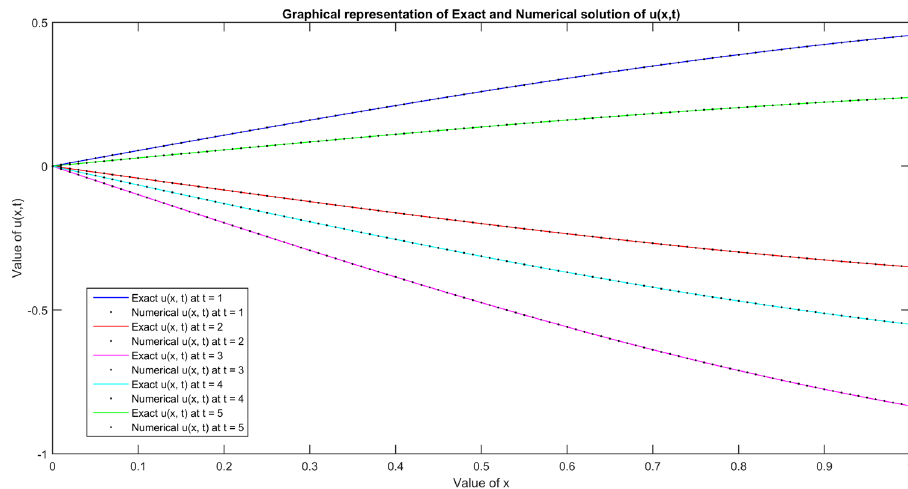
Figure 7: Comparison of ( ) u x t , at = t 1 , 2, 3, 4, and 5 for = N 101 , = α 30 , = β 5 , = t Δ 0.0001 , and = τ 0.5 using Method I regarding Example